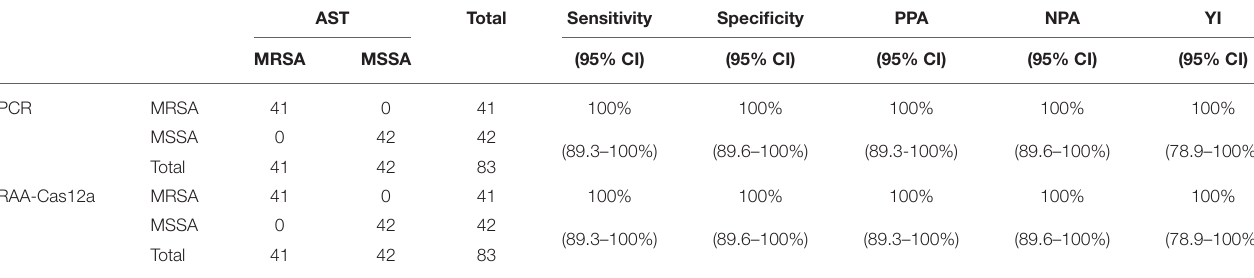
TABLE 1 | RAA-Cas12a, AST and PCR for clinical samples detection.